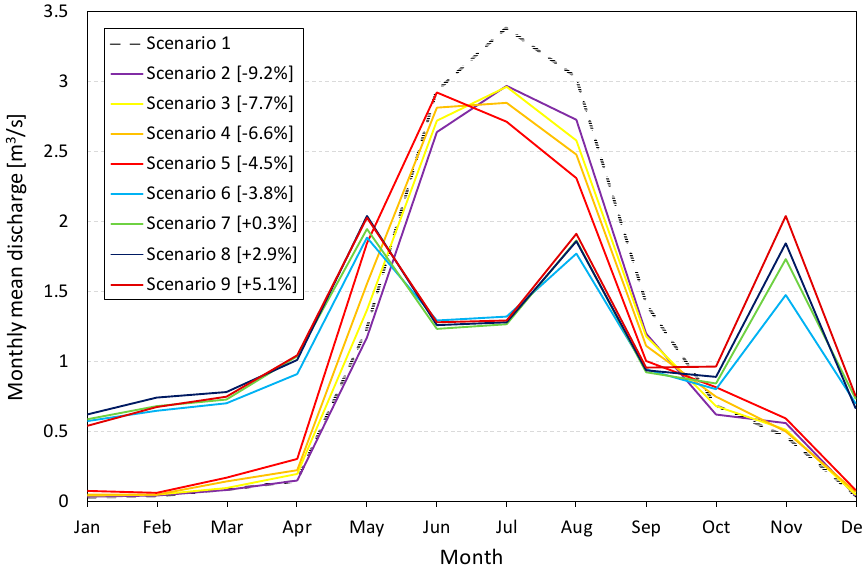
Figure 6. Average monthly discharge obtained with a 95% confidence interval at 2030 for all scenarios. The mean annual volume variation relative to climate scenario 1 is presented in brackets.